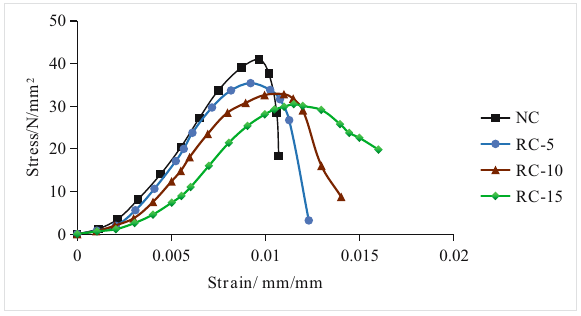
Figure 11: Stress – strain curve of RC.